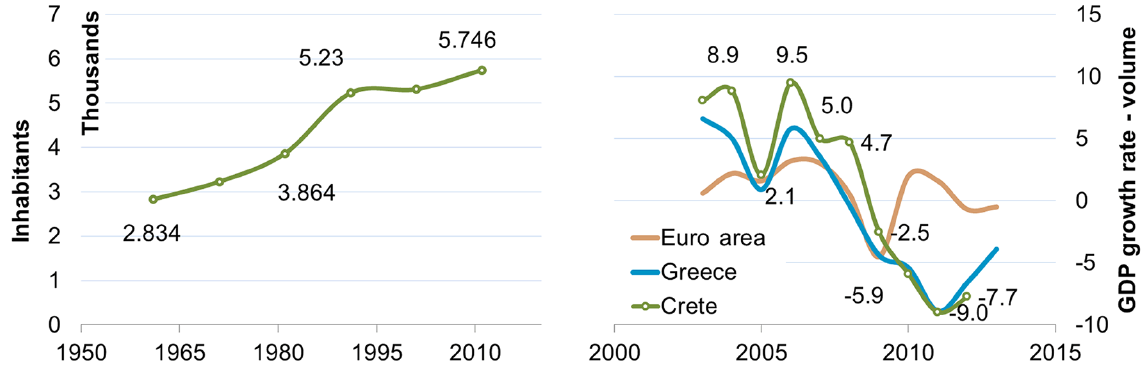
Figure 2. Left, population in Timpaki (Source: HSA, 2015); right, “real GDP growth rate – volume – percentage change on previous year” for the Euro area, Greece, and Crete (Source: EUROSTAT, 2015; HAS, 2015). Table 1. Units in ha (% of total). Source: HSA (2008). Area Olive trees Arable crops ∗ Horticulture Citrus Vine trees Total Timpaki 1100 (43%) 1005 (39%) 401.5 (16%) 37 (1%) 3 (0%) 2540.2 Phaistos 13090 (79%) 1805 (11%) 1404.3 (8%) 187.5 (1%) 62.4 (0%)